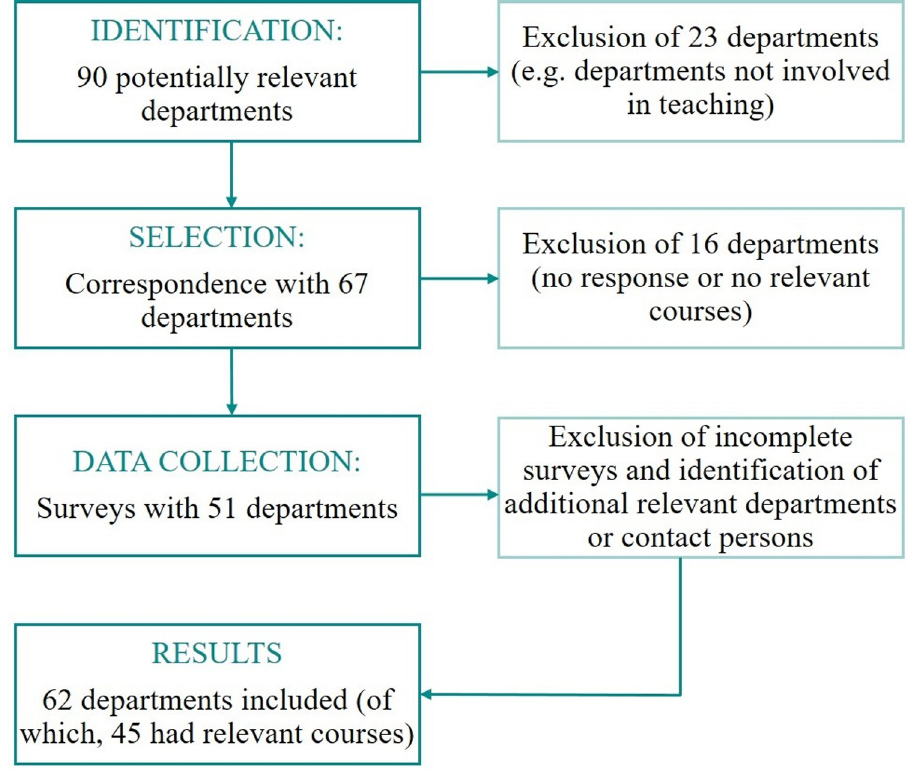
Fig 2. Recruitment of interviewees at the Medical Faculty of Hamburg. Description: All departments, including clinics, administration units and institutes, at the Medical Faculty of Hamburg were identified. The processes for selecting only teaching and relevant departments are shown on the right. The directors were contacted by telephone to obtain the names of the persons responsible for teaching communication-related content. A maximum of three reminders were sent by e-mail or telephone